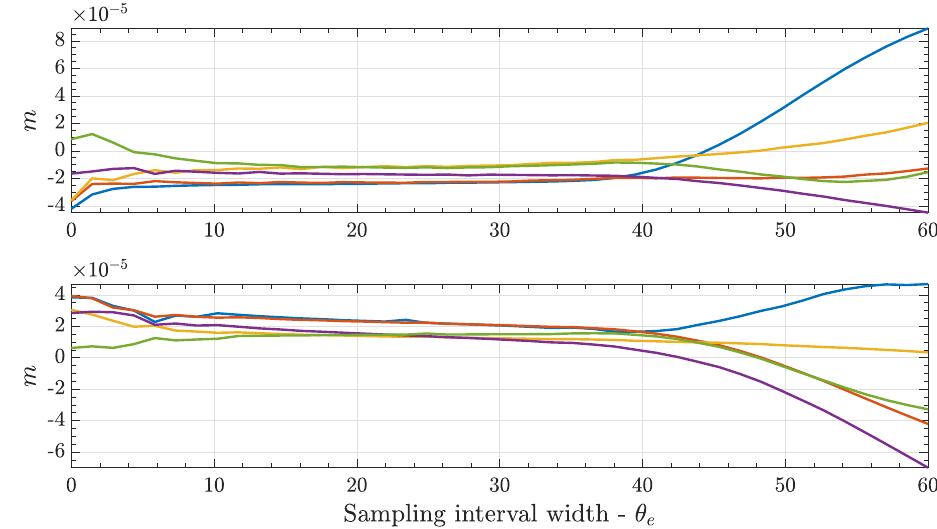
Figure 6. Variation of m for two different intra-commutations periods considering 5 randomly seeded back-EMF coefficient curves.